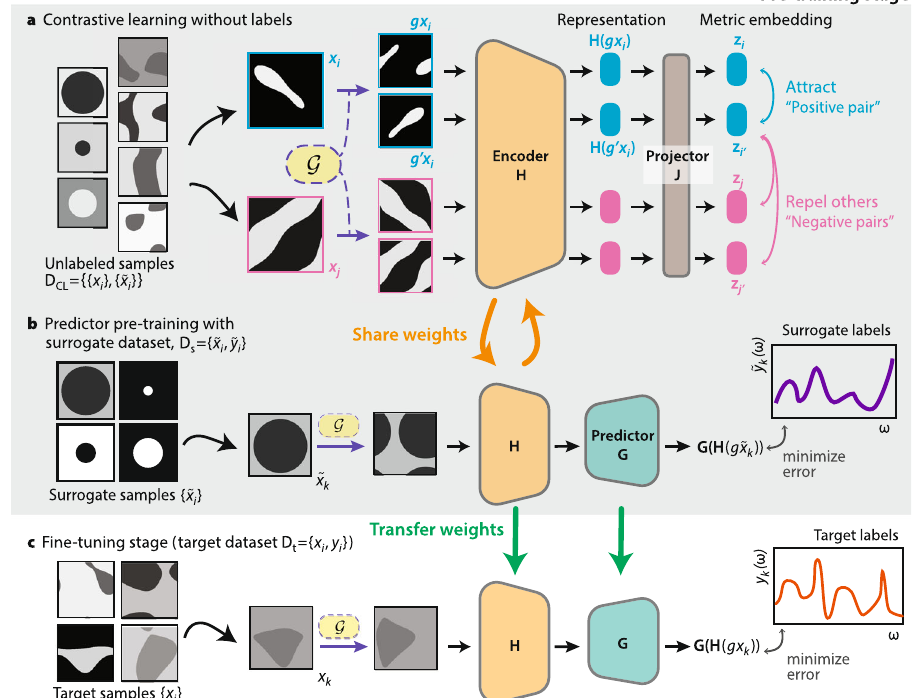
Fig. 2 Surrogate- and invariance-boosted contrastive learning (SIB-CL) framework. Network training proceeds via a pre-training stage ( a , b ) followed by a fi ne-tuning stage ( c ). The pre-training stage alternates a contrastive learning step a using unlabeled data D CL with a supervised learning step b using surrogate data D s . Contrastive learning encourages representations that respect the underlying invariances of the problem and supervised learning on the surrogate dataset attunes both representations and a predictor network to the desired prediction task. c After 100 – 400 epochs of pre-training, the encoder, and predictor weights are copied and subsequently fi ne-tuned by supervised learning on the target dataset D t